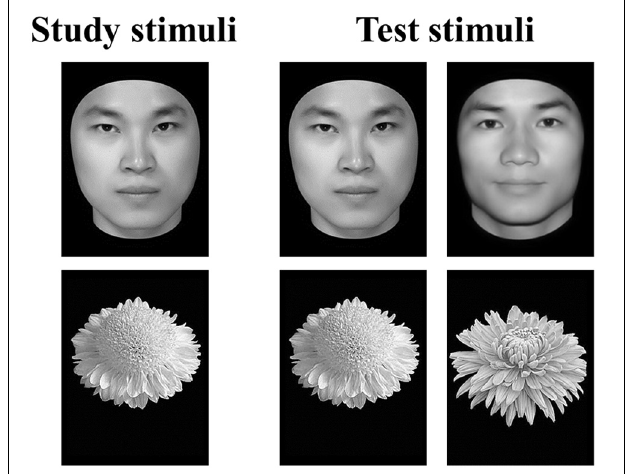
FIGURE 1 | Example stimuli and trial types in the old/new recognition task. In the study segment, participants studied a series of images of either faces or flowers. In the test segment, the studied images were shown with new images from the same category intermixed. Participants were asked to indicate which of the images had been shown in the study